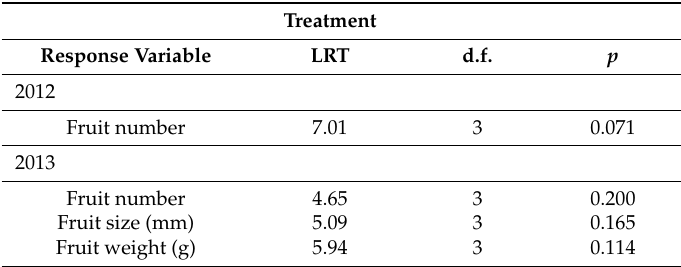
Table 3. Summary of minimum adequate models selected by inference on likelihood ratio tests. Effect of treatment (factor with four levels: control, concealed-nectar mix, mixed plots, and open-nectar mix) on fruit number per branch (2012 and 2013; 3 branches per plot, four plots per orchard, n = 192), and size (mm) and weight (g) of harvested fruit (2013) in orchards. Degrees of freedom (d.f.), test statistics (LRT) and p -values from likelihood ratio tests are shown.